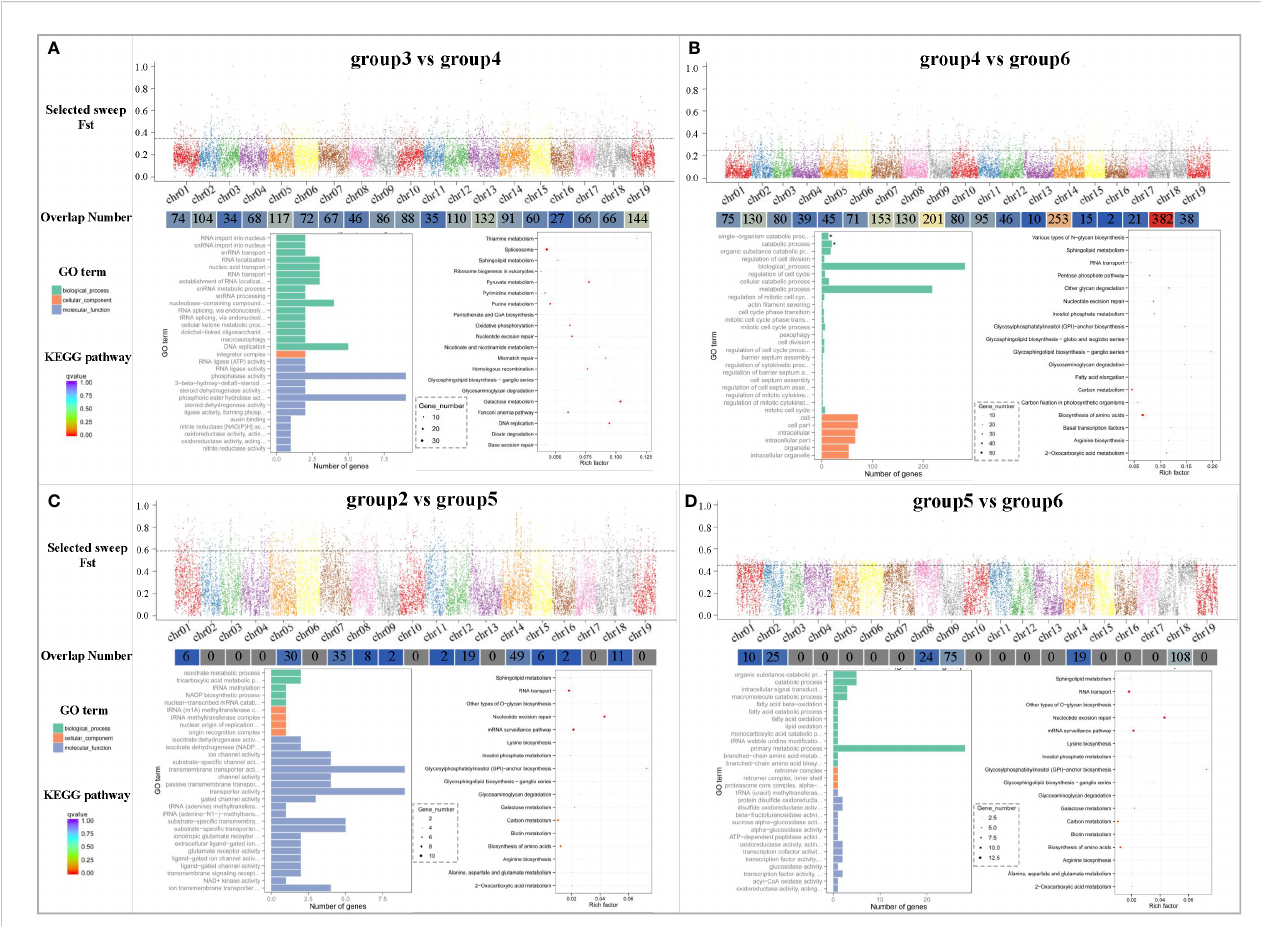
FIGURE 5 Selective sweep regions and gene enrichment analysis of major groups. (A) group3 vs. group4; (B) group4 vs. group6; (C) group2 vs. group5; and (D) group5 vs. group6. Each group includes the Fst distribution map ( X -axis represents different chromosomes, Y -axis represents the Fst value in the corresponding chromosome window, and the dotted line represents the selection threshold top 5%); overlap number ( X -axis represents different chromosomes, and Y -axis represents the number of corresponding overlaps); and GO term and KEGG pathway enrichment of the candidate selective sweep genes. The size of the bubble represents the number of genes in the corresponding GO category. The color of the bubble shows the corresponding P -value. Rich factor shows the percentage of enriched genes out of the total number in the GO